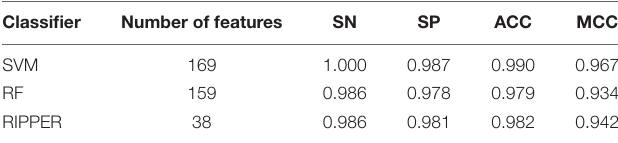
TABLE 1 | Performance of incremental feature selection (IFS) with support vector machine (SVM), random forest (RF), and repeated incremental pruning to produce error reduction (RIPPER) for classifying different tumor cells.